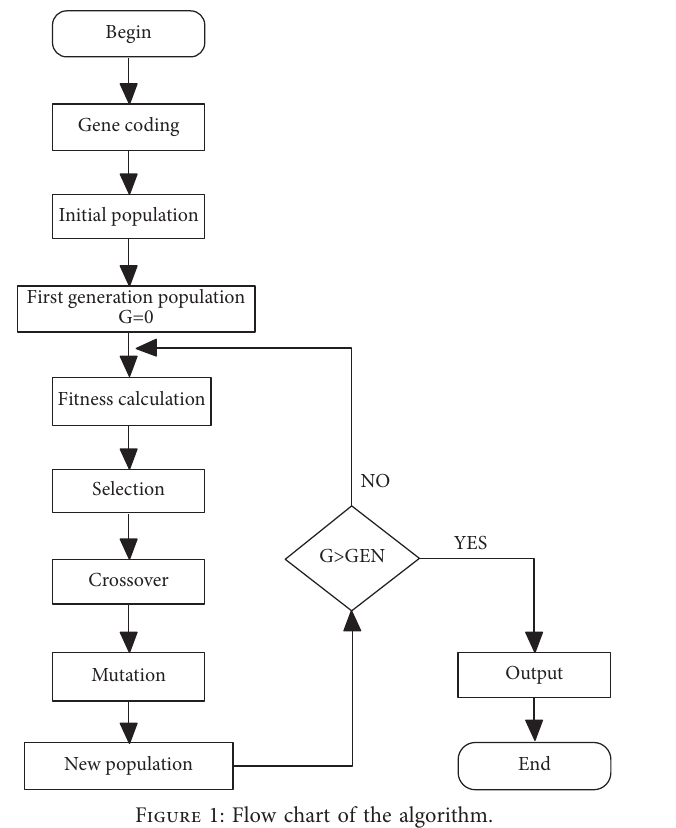
Figure 1: Flow chart of the